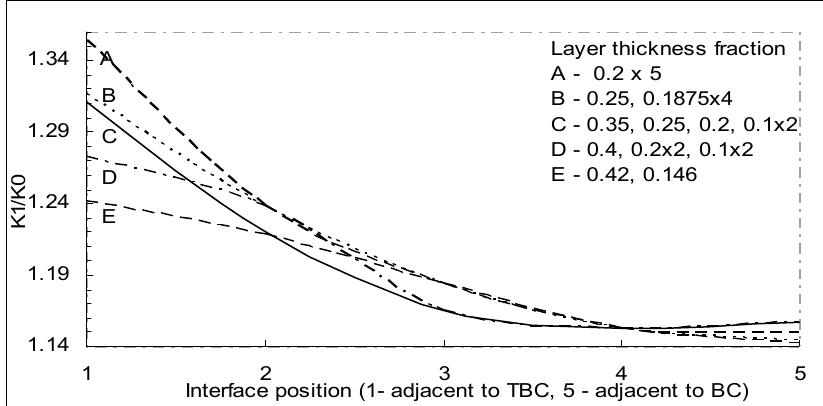
Figure 13. Effect of different layer width (fraction of total TBC width) on K 1 / K 0 for 5-layer FGM. Figure 13. E ff ect of di ff erent layer width (fraction of total TBC width) on K